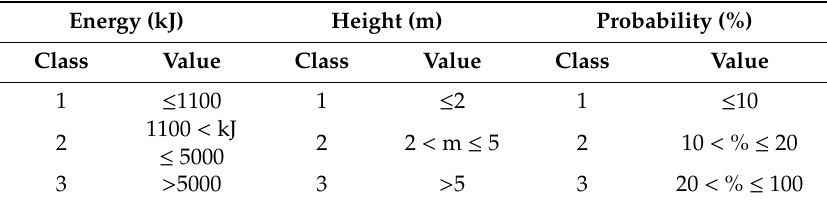
Table 5. Classification of energy, height, and probability raster outputs.